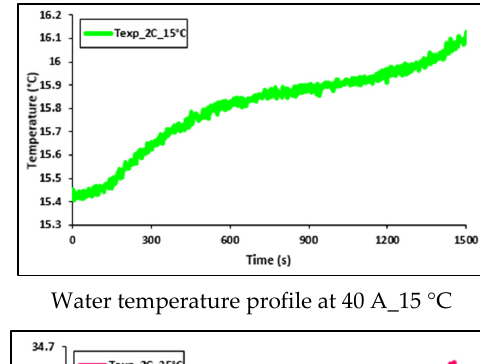
Figure 17. Transient temperature profile of water flow at 20 A with 5 °C, 15 °C, 25 °C, and 35 °C.